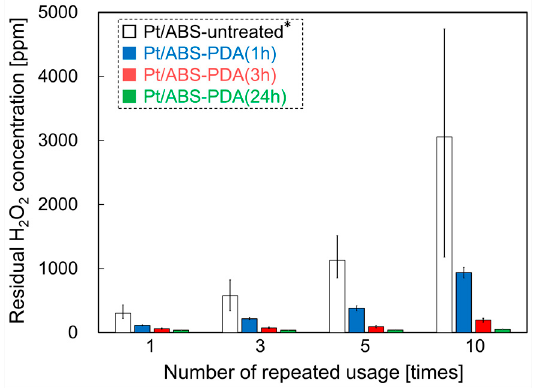
Figure 7. Catalytic durability of Pt/ABS samples with or without PDA coating: the relationship between the number of usage cycles and the residual H 2 O 2 concentration. * The data for the Pt/ABS- untreated are the same as in our previous report [17].